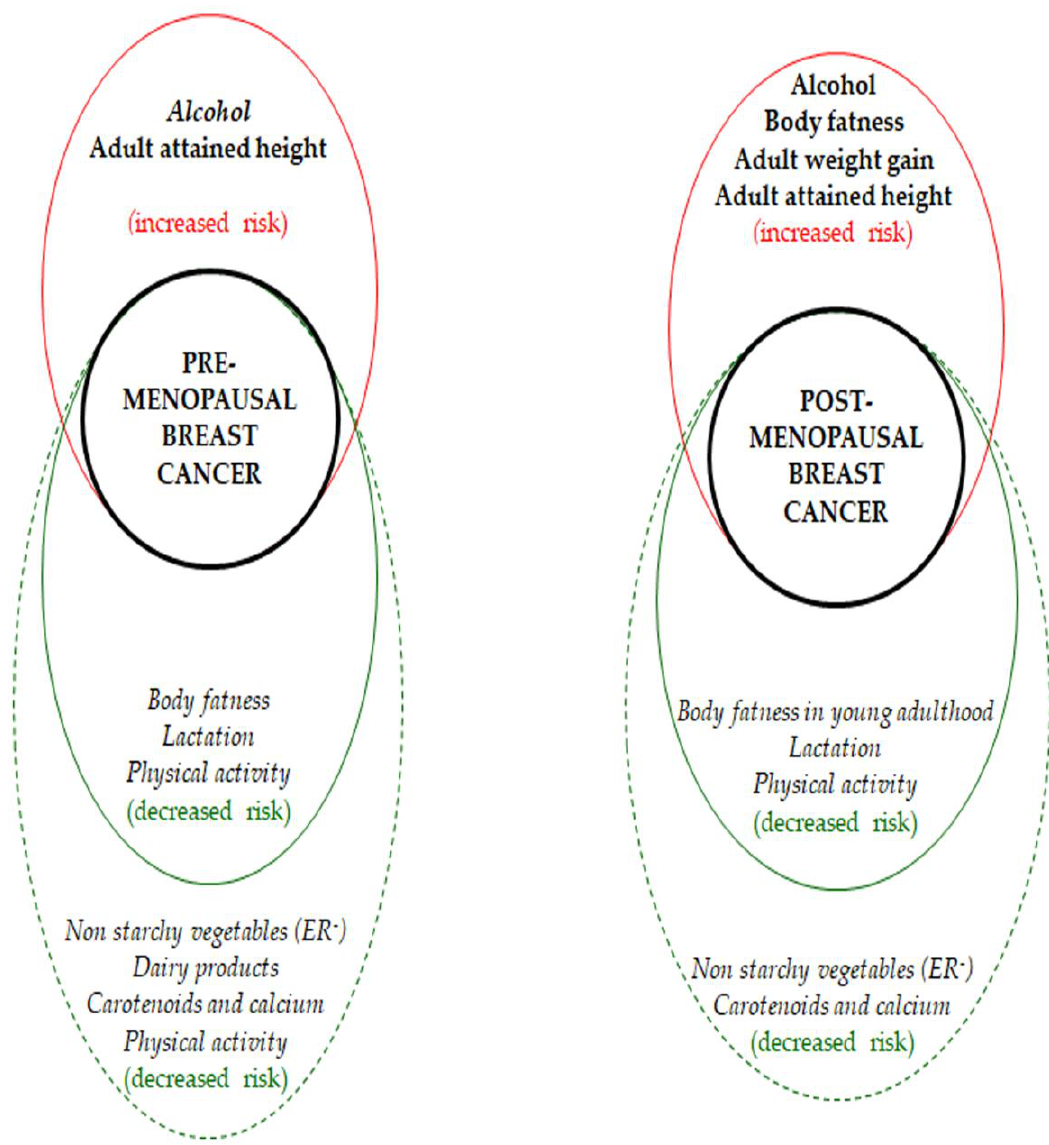
Figure 2. Main findings on breast cancer risk [19]. Red circle: direct correlation. Green circle: inverse correlation. Strong evidence: continuous line. Limited, but suggestive, evidence: dotted line. Convincing evidence: bold. Probable evidence: italic.